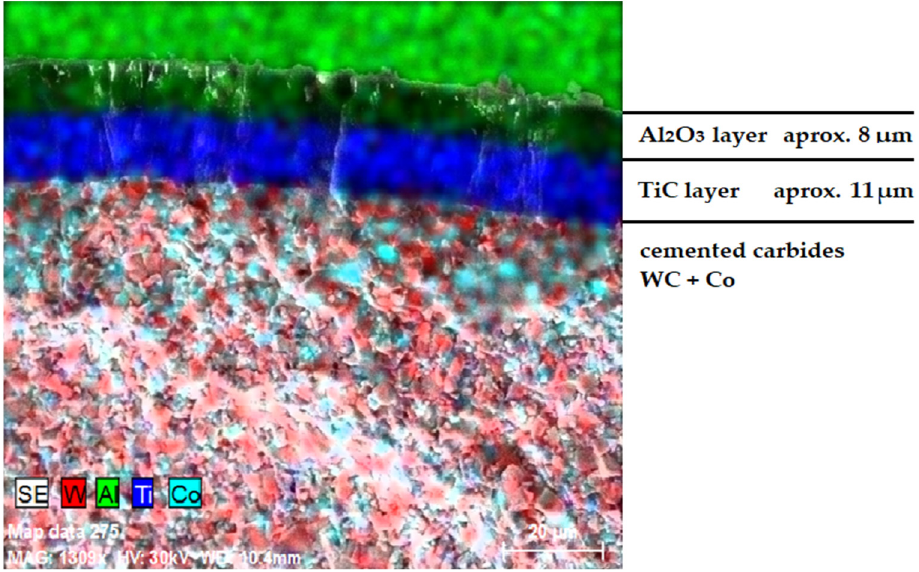
Figure 4. Coating thickness of CNMG 120408-MP3 WPP10S carbide cutting insert.